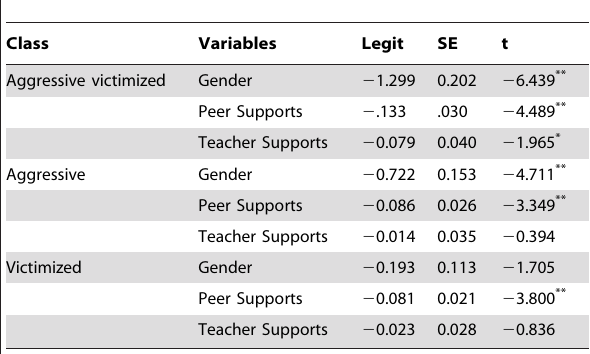
Table 3. Gender (Boys= 0, Girls =1), Peer Supports and Teacher Supports as Covariates with the general group as the comparison